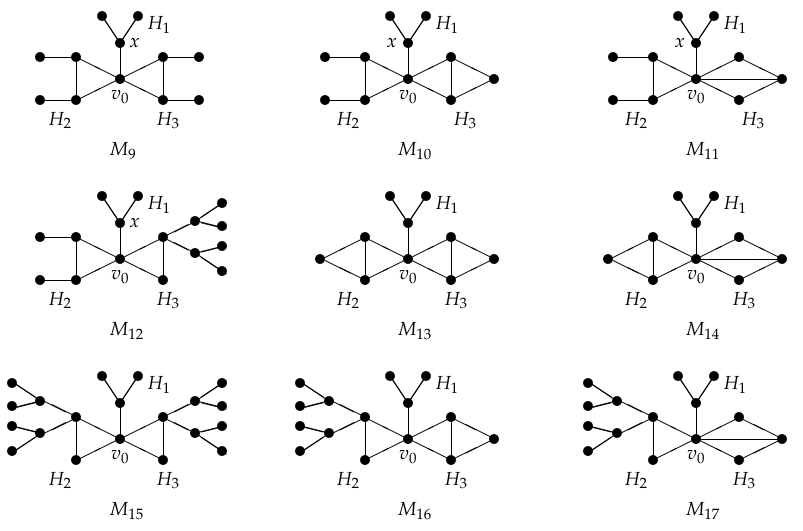
Figure 4. Nine special 4-cutwidth critical